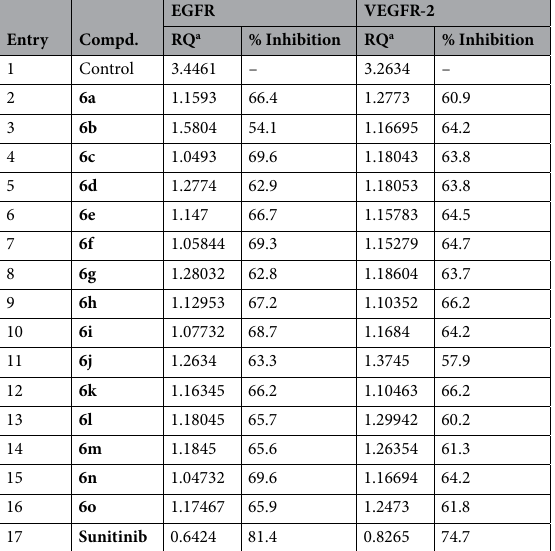
Table 4. Inhibitory properties of the synthesized spiro-3-indolin-2-ones 6a ‒ o and standard reference (sunitinib) against EGFR and VEGFR-2. a RQ is the relative